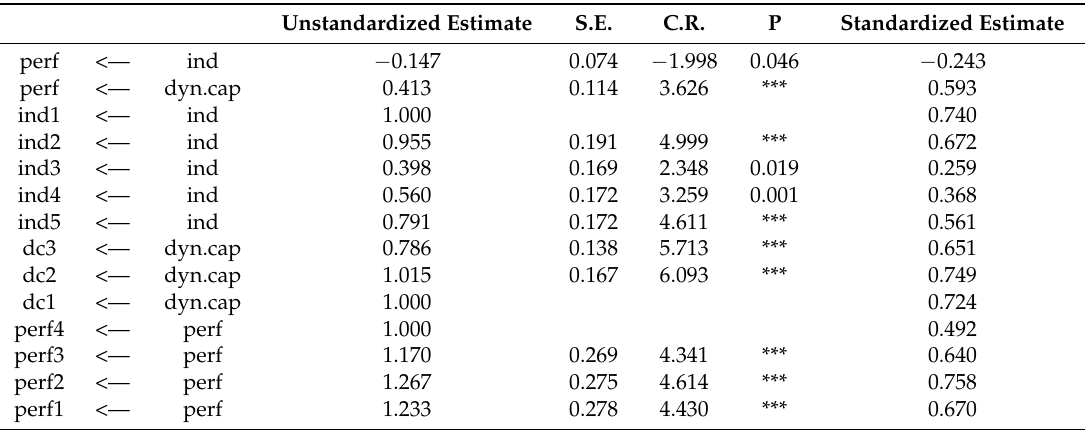
Table 6. Regression Weights (Unstandardized and